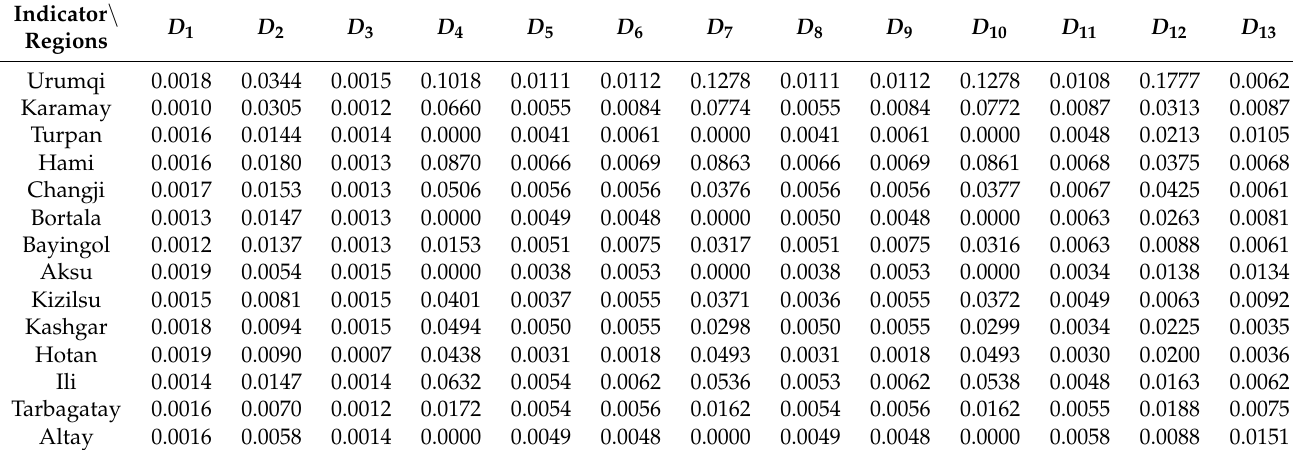
Table A5. Weighted normalized TOPSIS table.